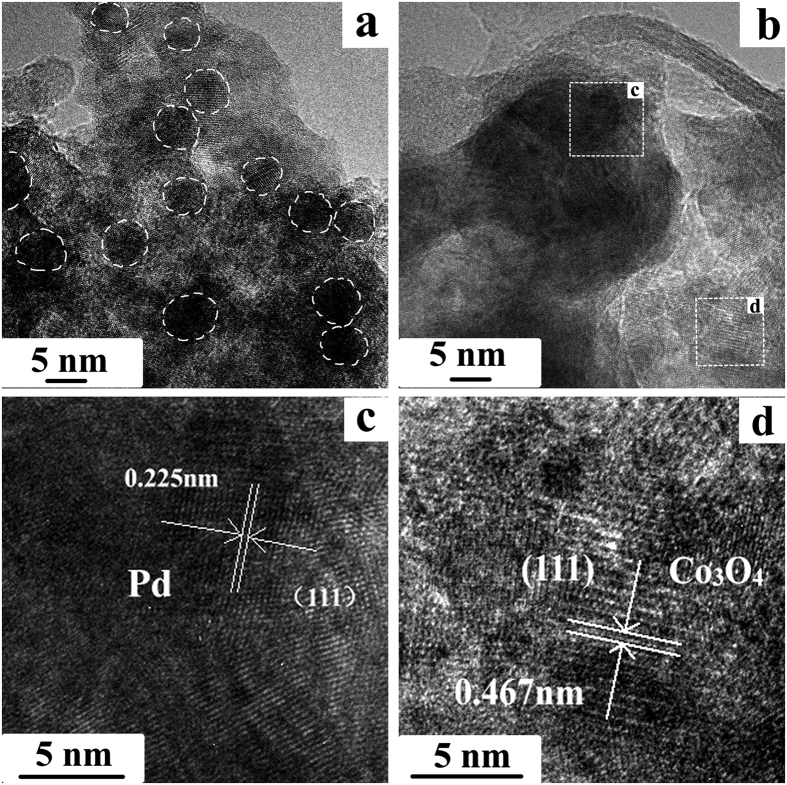
(a,b) TEM images of Pd-Co3O4(wt 1:1) catalyst; (c,d) enlarged images of white rectangles marked in (b).